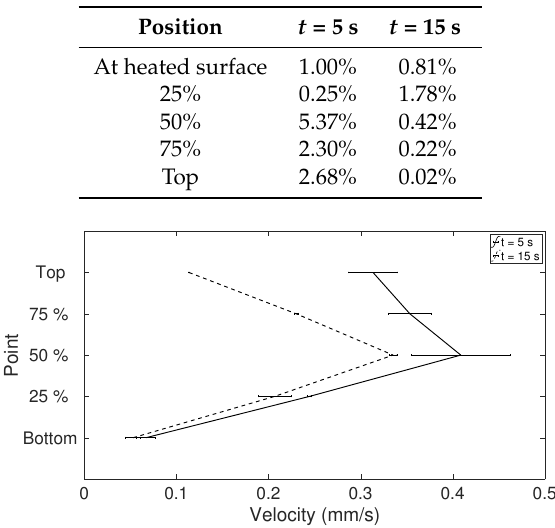
Figure 3. The mean velocity in the five points used in the repeatability study at t = 5 and 15 s for 10 experiments when T plate = 333.15 K. The precision error with a 95% confidence interval in each point is shown with error bars. Point 1 is located at the heated surface and Point 5 is located at the top of the corrected data. Points 2–4 are found in between Points 1 and